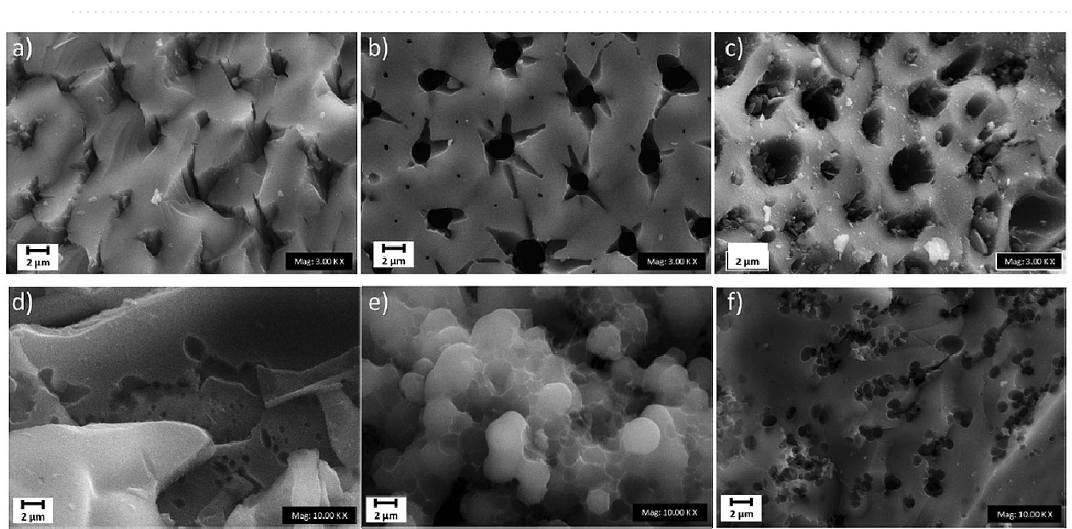
Figure 3. FESEM photographs of the PAC based on activation solutions of ( a ) RSS H 2 SO 4 , ( b ) RSS KOH, ( c ) RSS NaOH, ( d ) RS